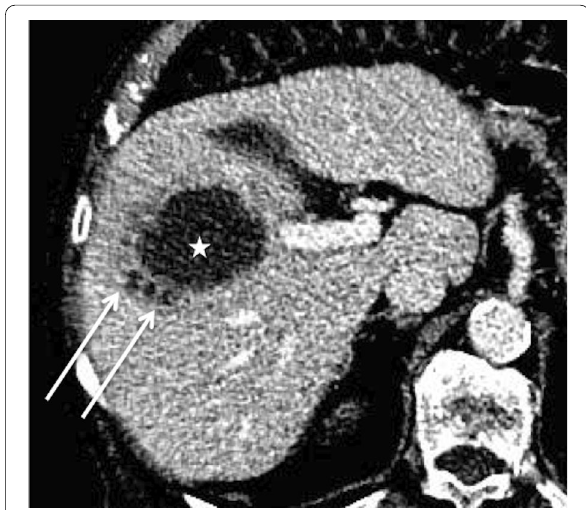
Fig. 26 Escherichia Coli abscess in an 89-year-old male. Axial computed tomography on portal venous phase shows three small hypoattenuating areas (arrows) forming the “cluster sign” and a large central hypoattenuating cavity (star)